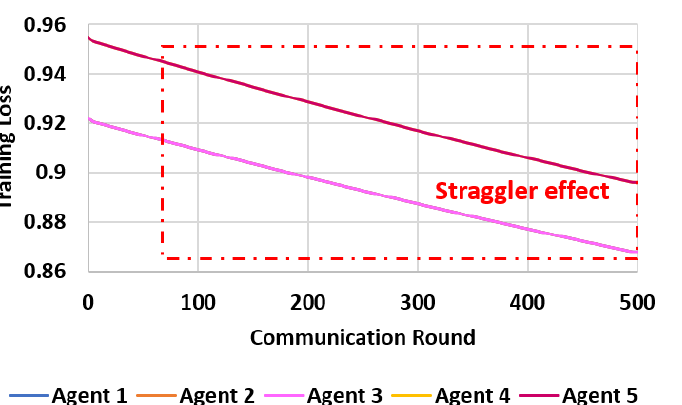
Figure 5. Straggler effects on participating FL agents’ (five agents and three stragglers) model loss for the prediction of critical infrastructure outage.